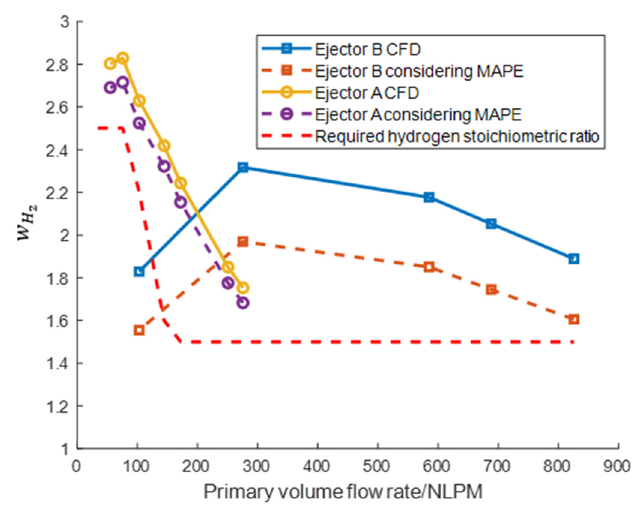
Figure 9. Hydrogen entrainment ratio achieved by the dual-ejector system under required stoichiometric ratio.